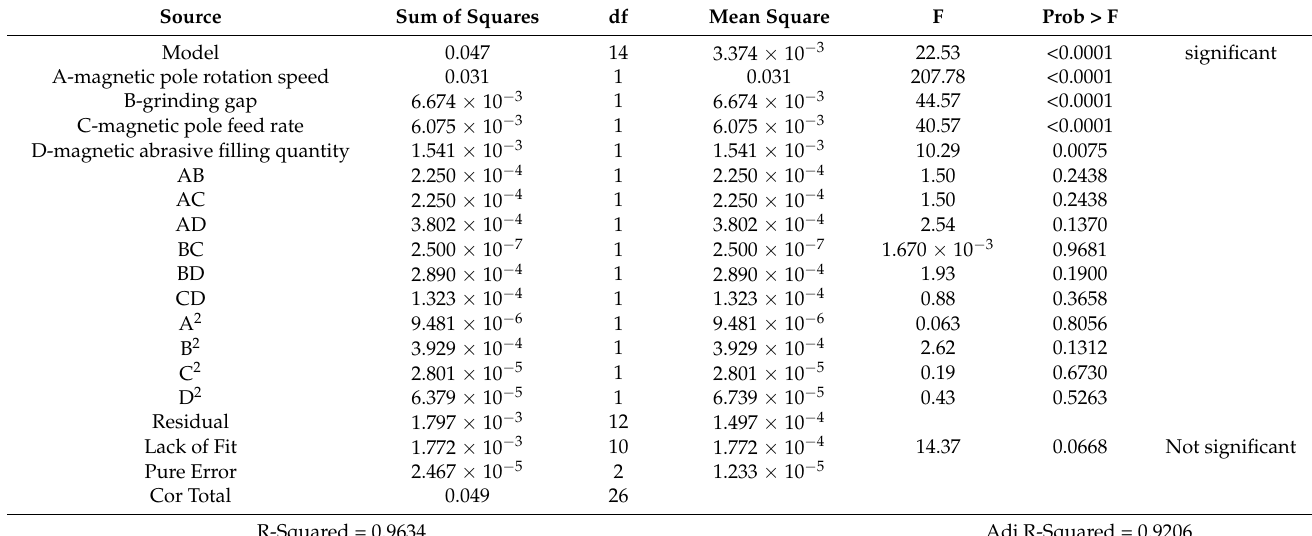
Table 5. Variance analysis of surface roughness regression